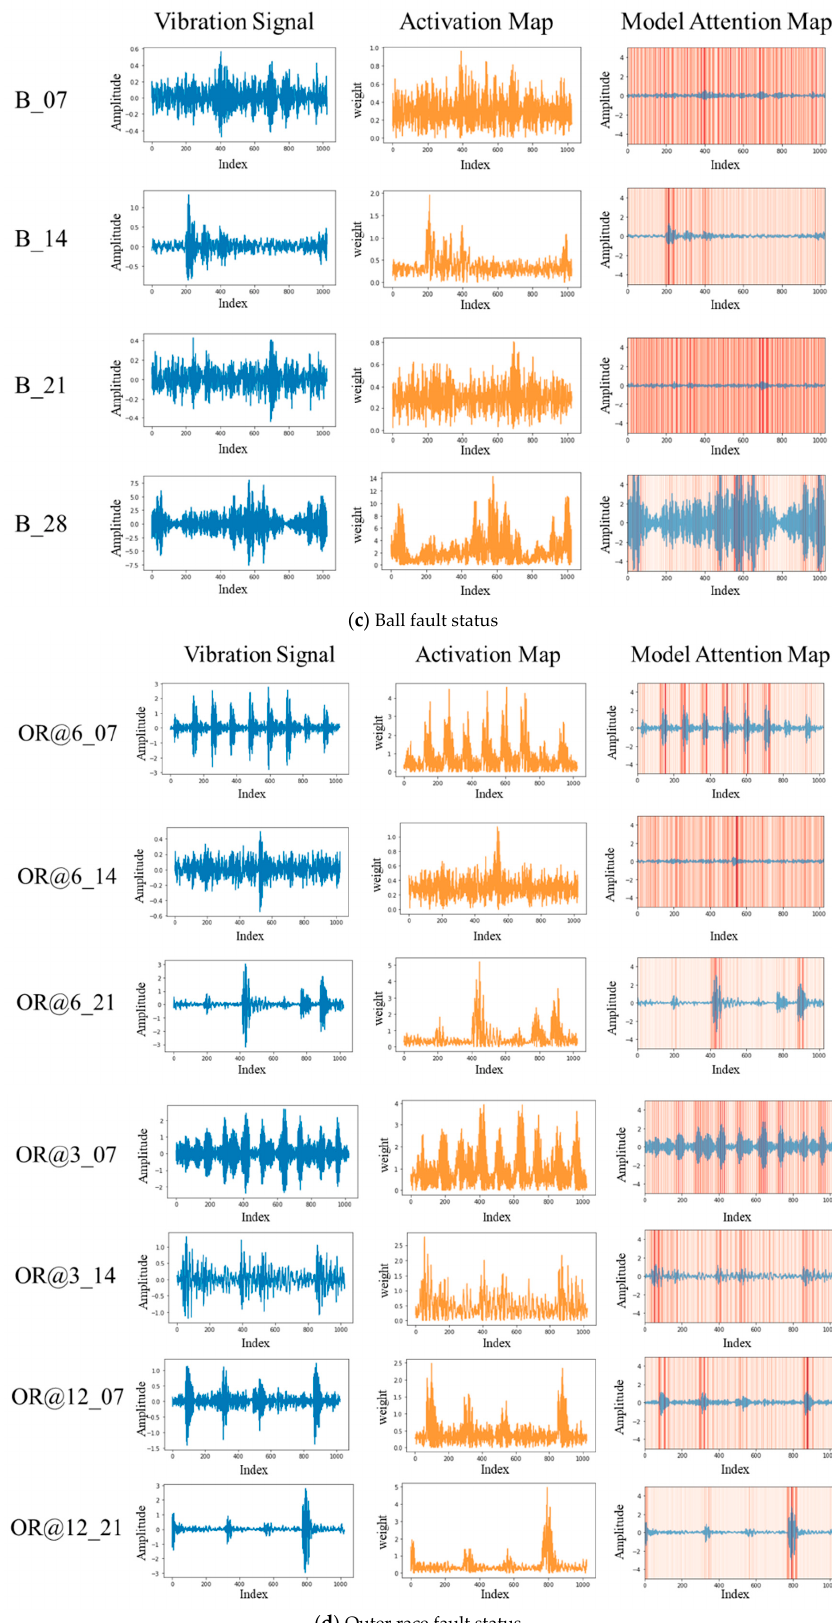
Figure 10. Model attention maps for different types of bearing faults.